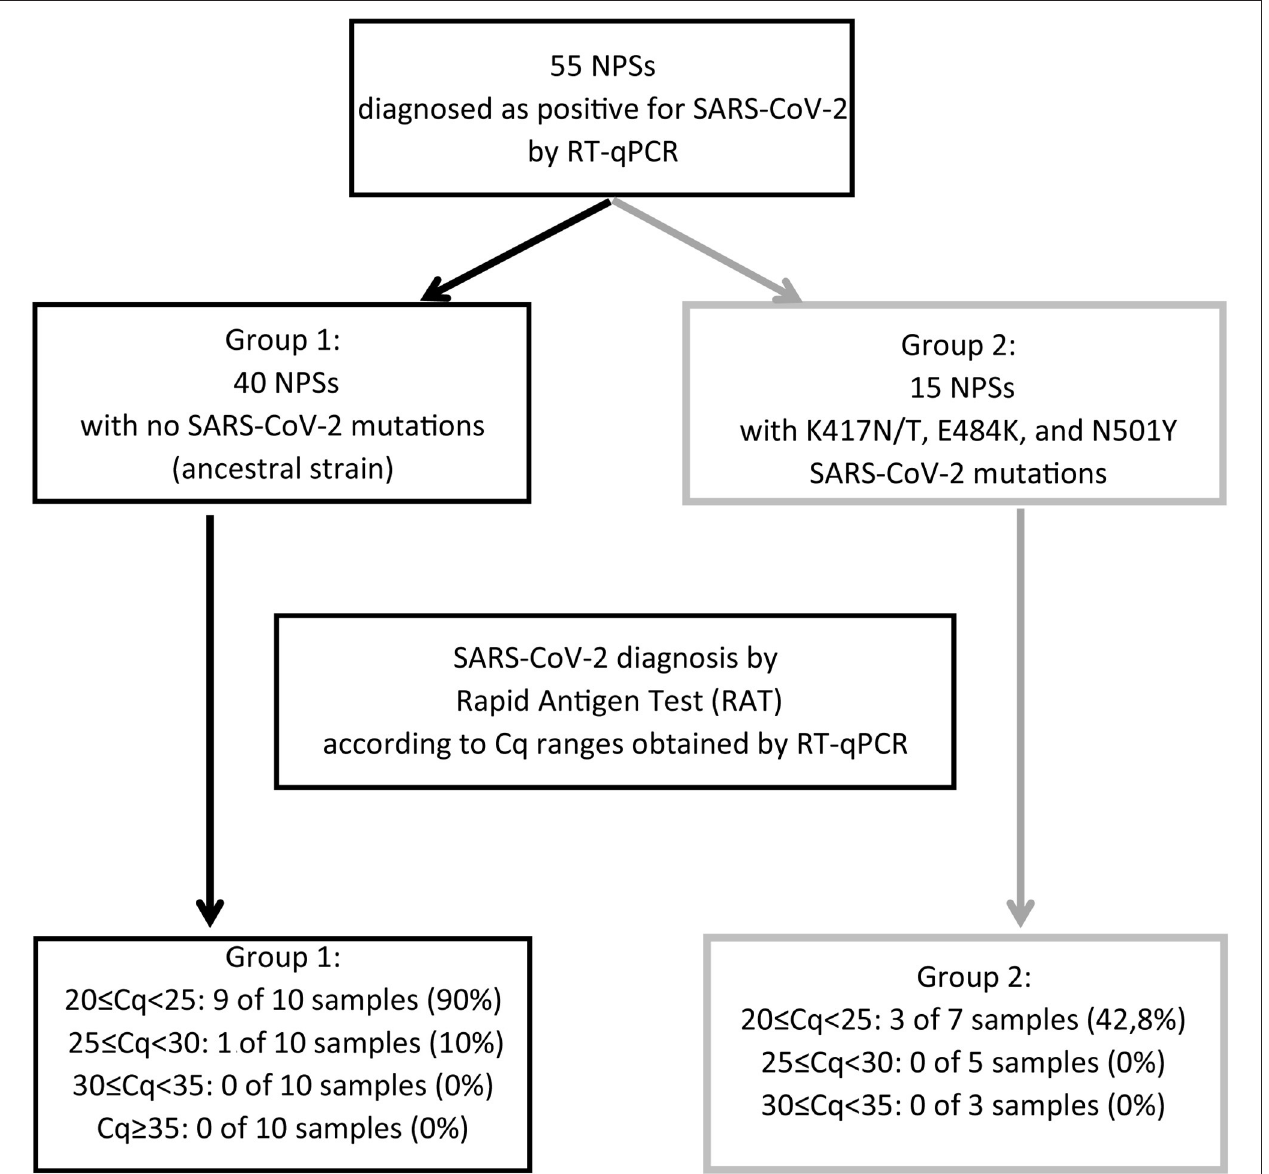
FIGURE 3 | Summary of the results obtained for the analysis of the 55 nasopharyngeal swab samples (NPSs) evaluated by Rapid Antigen Test (RAT). The 55 NPSs were diagnosed as positive for SARS-CoV-2 using the ORF1ab probe following a one-step strategy. From them, 40 NPSs showed no mutations for SARS-CoV-2 (black arrow) (Group 1). By contrast, in the other 15 positive samples we identified the SARS-CoV-2 variants K417N/T, E484K, and N501Y (gray arrows) (Group 2). Each one of these groups were used to evaluate the sensitivity of the Rapid Antigen Test (RAT) according to the Cq ranges previously obtained by RT-qPCR. The group 1 showed a 90% of positive diagnosis using the RAT. However, the group 2 showed only a 42.8% of positive diagnosis. Importantly, all of them were grouped in the 20 ≤ Cq < 25